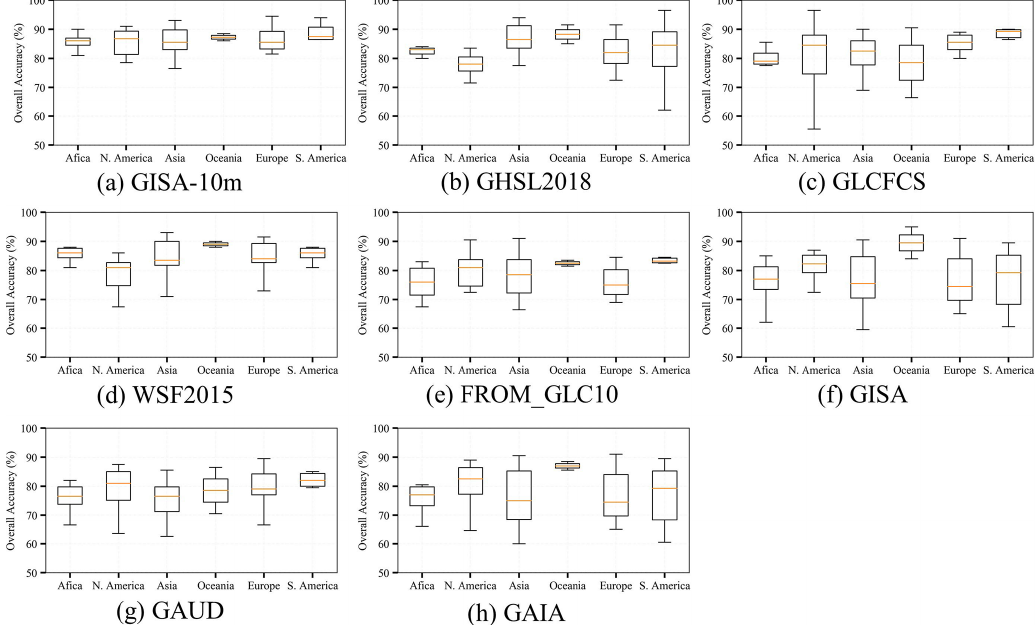
Figure 6. Box plots of the overall accuracy for GISA-10m and existing datasets in the six